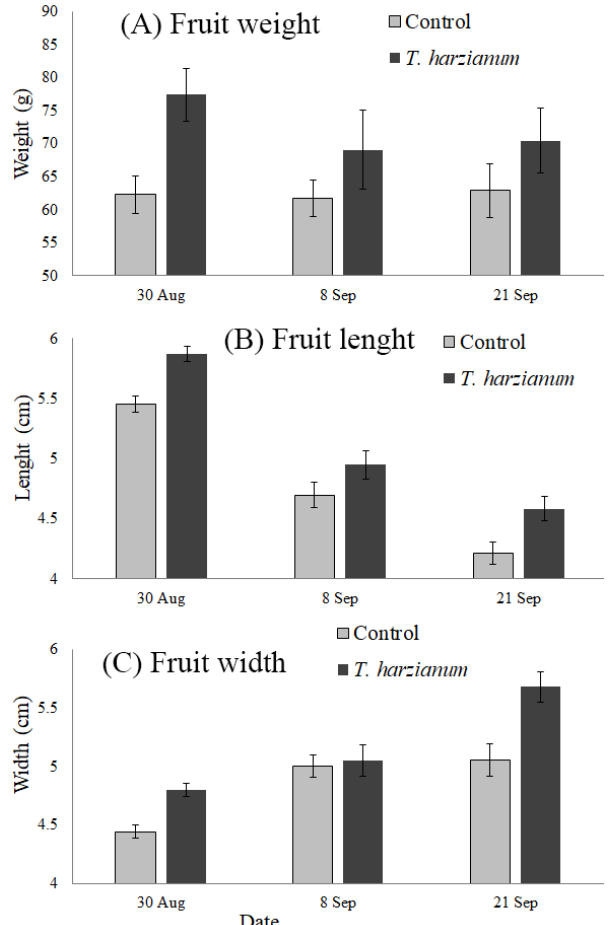
Figure 10. Mean values ( ± standard errors) of fruit weight, length, and width from tomato plants inoculated with T. harzianum T22 and control ones at the three sampling dates.